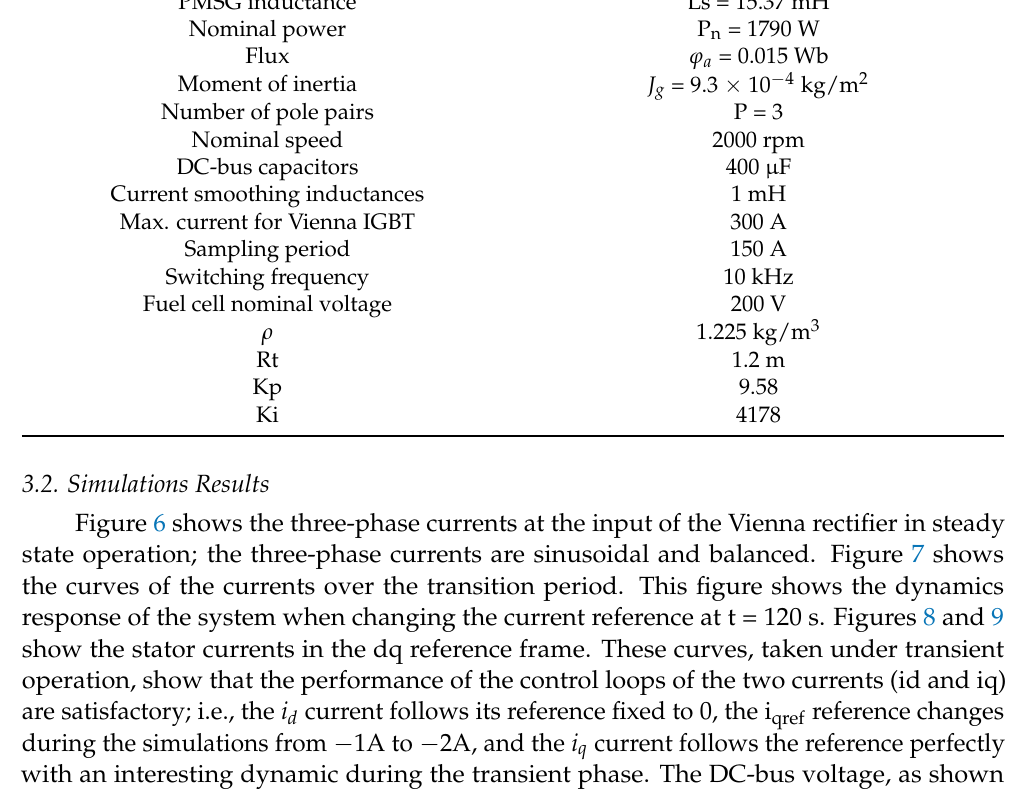
Table 2. Parameters of the PMSG and wind turbine